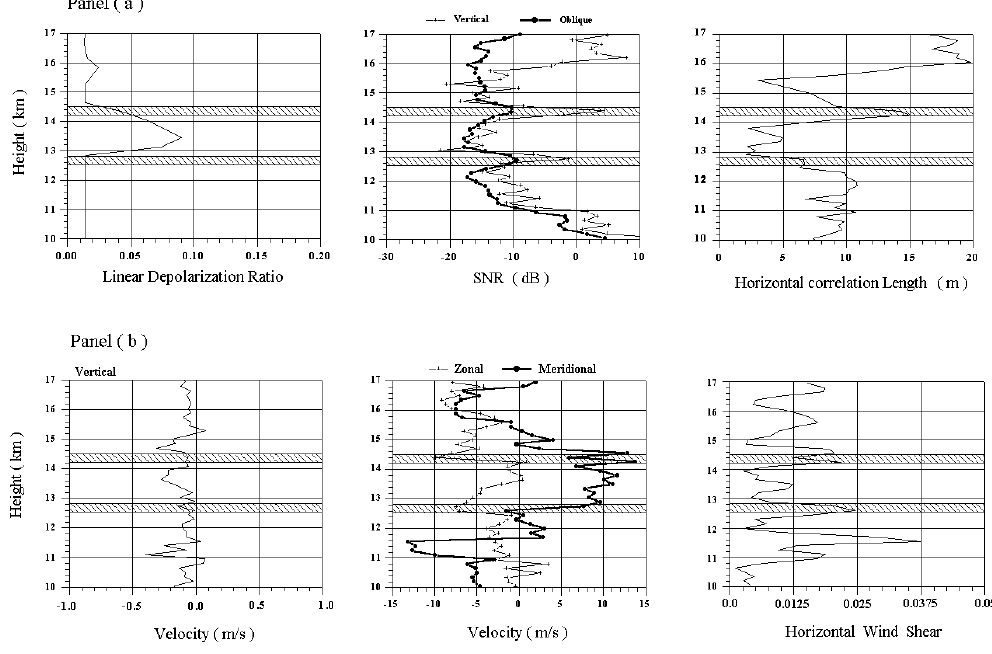
Fig. 5. Panel (a) Height profiles of lidar LDR, radar vertical and oblique beam SNR and derived horizontal correlation lengths for Case 1. The horizontal bands in this figure represent approximately the cloud boundaries as indicated by lidar LDR measurements. Panel (b) Height profiles radar vertical, zonal and meridional winds and computed vertical shear in horizontal winds for Case 1. The horizontal bands in this figure represent approximately the cloud boundaries as indicated by lidar LDR